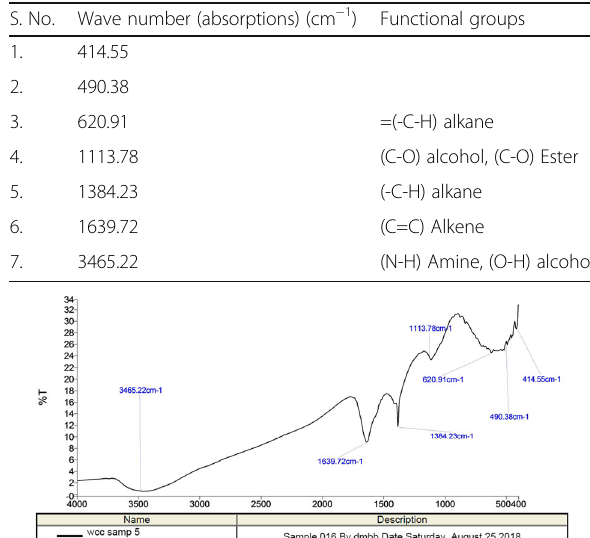
Table 2 FT-IR analysis A. muricata